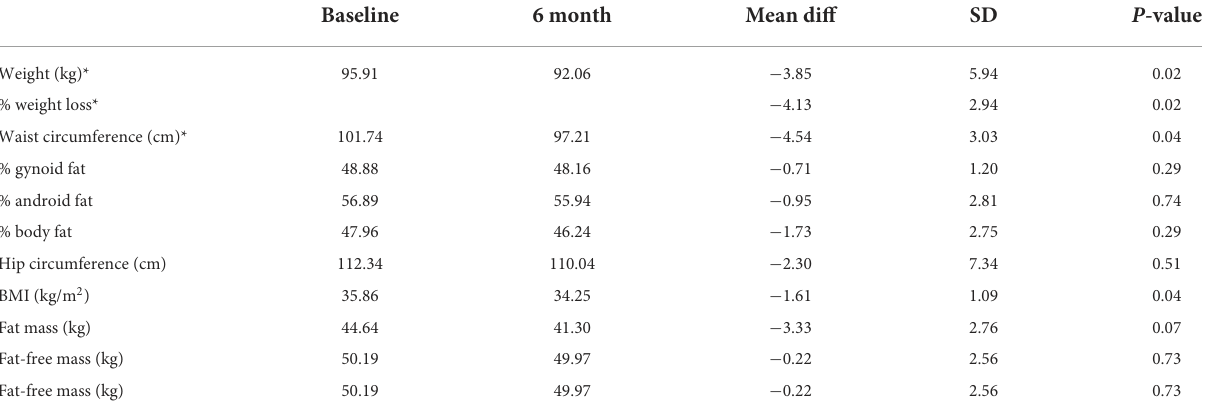
TABLE 2 Change in anthropometrics and body composition in study ( n = 8).